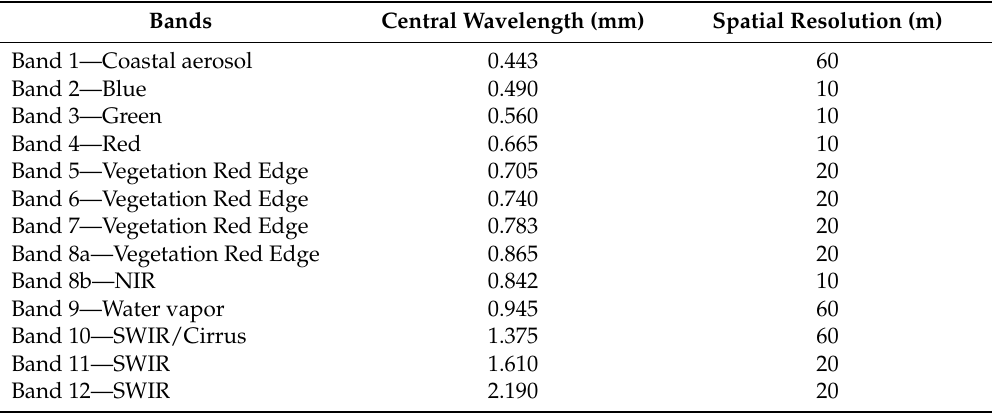
Table 1. Central wavelengths and spatial resolutions of all 13 Sentinel-2A and -2B bands.